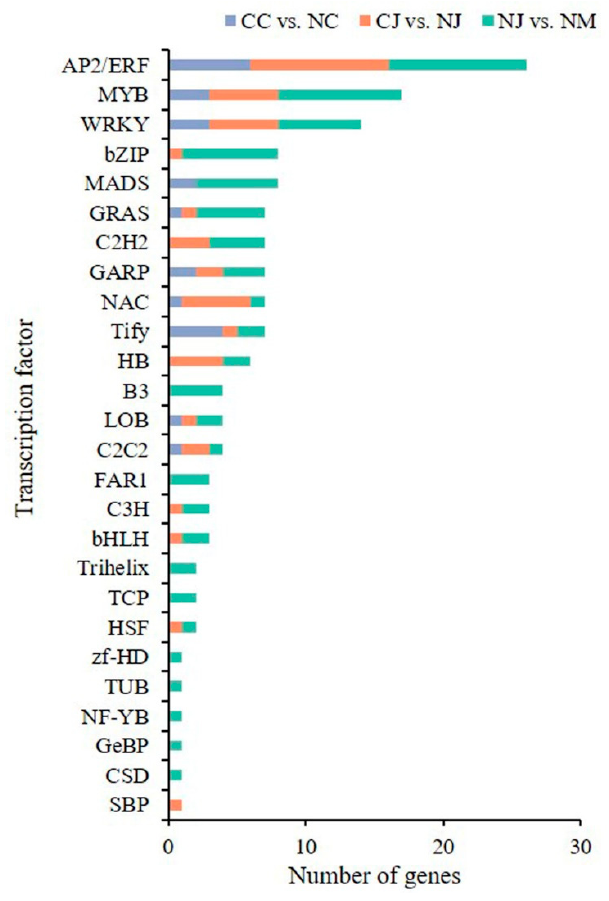
Figure 6. Transcription factor families of the DEGs in CC vs. NC, CJ vs. NJ, and NJ vs. NM.